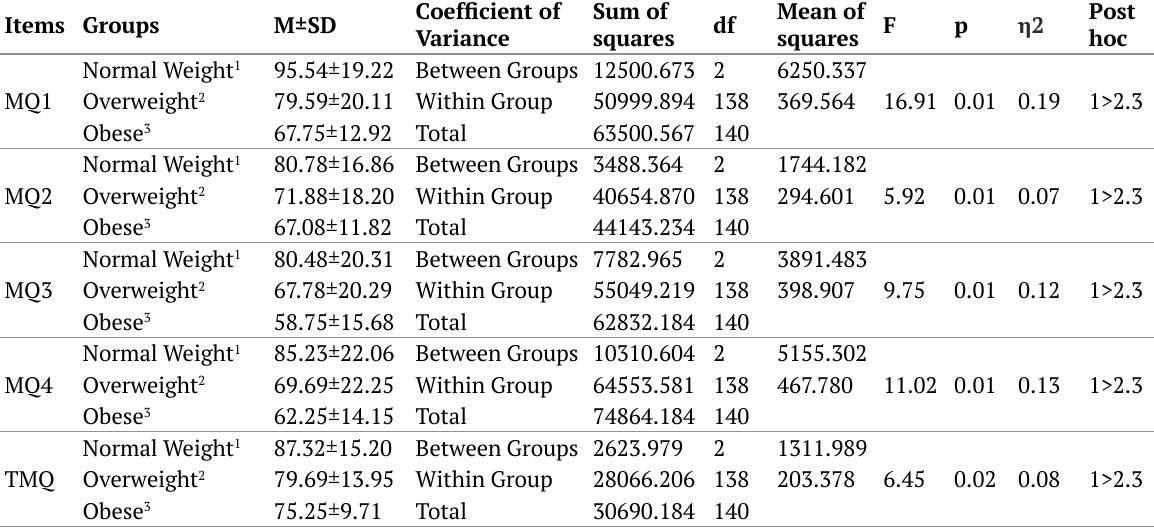
Table 6. Results of Comparing the Measurement Values According to the KTK Motoric Performance Categories Items Groups M±SD